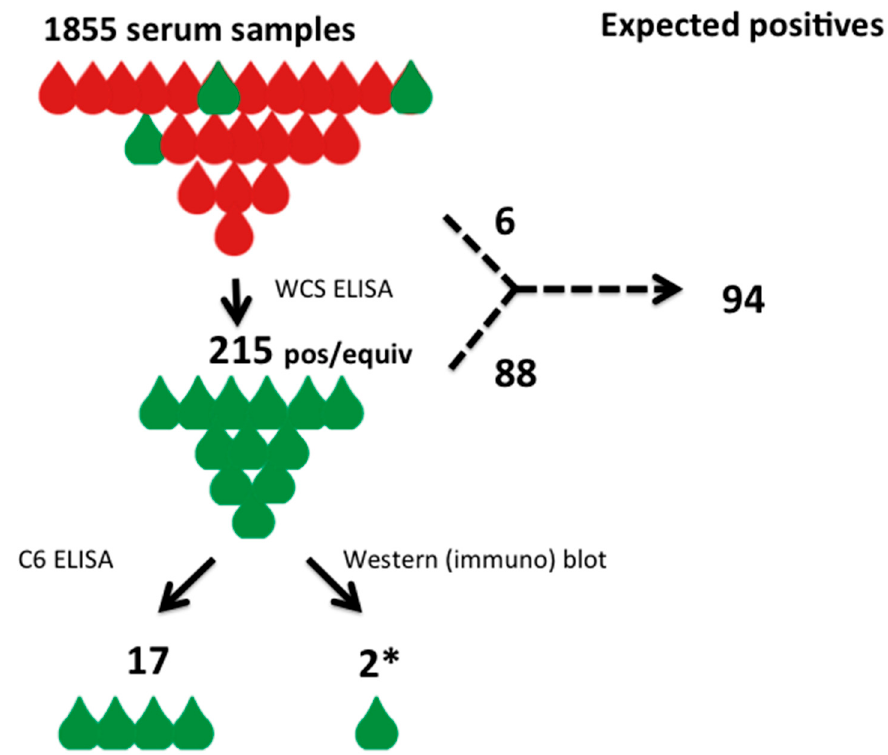
Figure 1. A schematic diagram of the seroprevalence study of Hatchette et al. (2015) [35] indicating observed results and the results that would be expected given the known sensitivity and specificity of the WCS ELISA. Red drops indicate non-reactive serum samples, green drops indicate those with evidence of anti- Borrelia antibodies. The study data is cartooned on the left with the tests performed and the observed results indicated. The expected results, based on known test characteristics, is shown on the right. The asterisk indicates that the 2 positive western blot samples were only positive using relaxed CDC criteria.